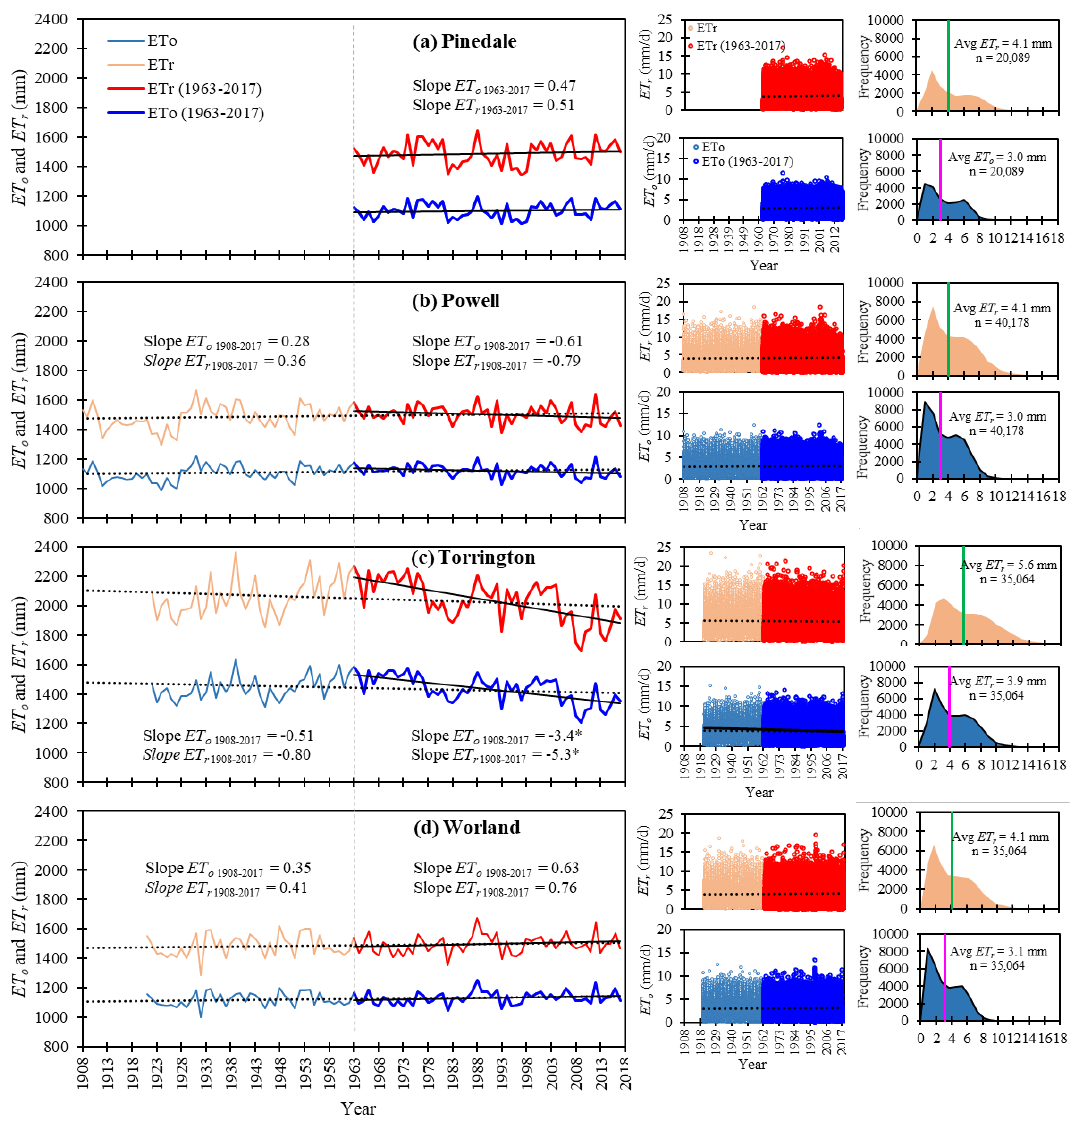
Figure 7. Temporal variation of grass and alfalfa reference evapotranspiration ( ET o and ET r , mm) at annual and daily time scale over the period−of−record and from 1963−2017 along with histogram distribution of daily ET o and ET r at ( a ) Pinedale, ( b ) Powell, ( c ) Torrington, and ( d ) Worland, WY. (Pink and green lines in the histograms represent the mean daily ETr and ETo , respectively.) On a decadal scale, all four stations experienced a statistically significant increase in ET o (as well as in ET r at all stations expect Powell) from 1981−1990 (Table 4). The magnitude of these increases was 11.4, 5.3, 19.8, and 14.5 mm year −1 for ET o at Pinedale, Powell, Torrington, and Worland, respectively; similarly, increases for ET r were 18.4, 9.4 (not statistically significant), 31.4, and 24.0 mm year −1 . Only Worland experienced a statistically significant decline in ET o and ET r , specifically from 1951−1960, with ET o changing at a rate of −11.3 mm year −1 and ET r changing at a rate of −20.2 mm year −1 (Table 4). This decade also saw significant declines in u and VPD and a significant increase in RH . Powell, which is just 120 km northwest of Worland, saw similar conditions during this decade, but the reductions in ET o and ET r were not statistically significant.